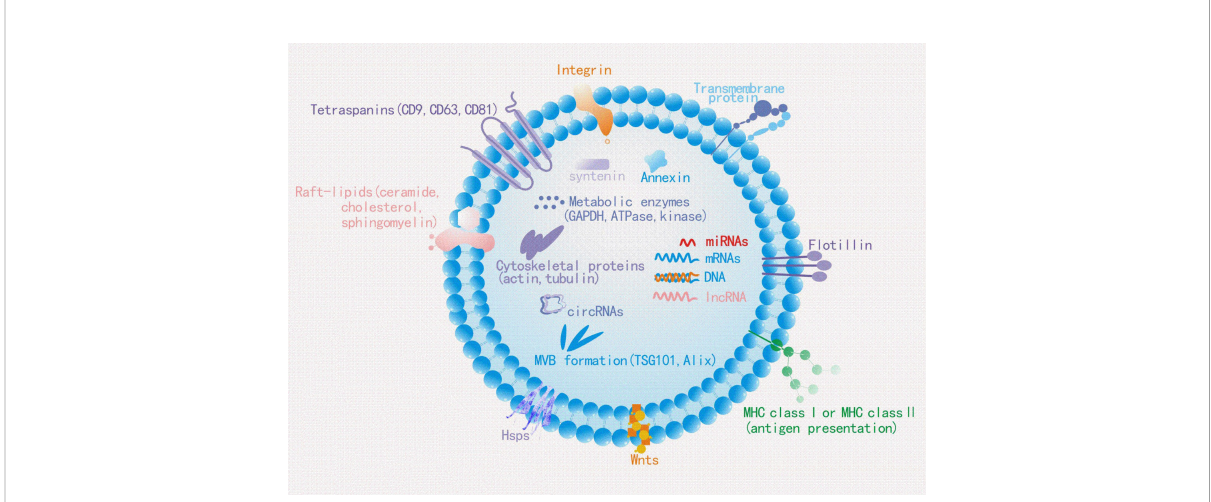
FIGURE 2 Typical exosome structure: Exosomes are surrounded by a phospholipid bilayer and contain different types of cell surface proteins, lipids, intracellular proteins, DNA, RNA, and metabolites. Several molecules are used as exosome markers (CD9, CD63, CD81, TSG101, and